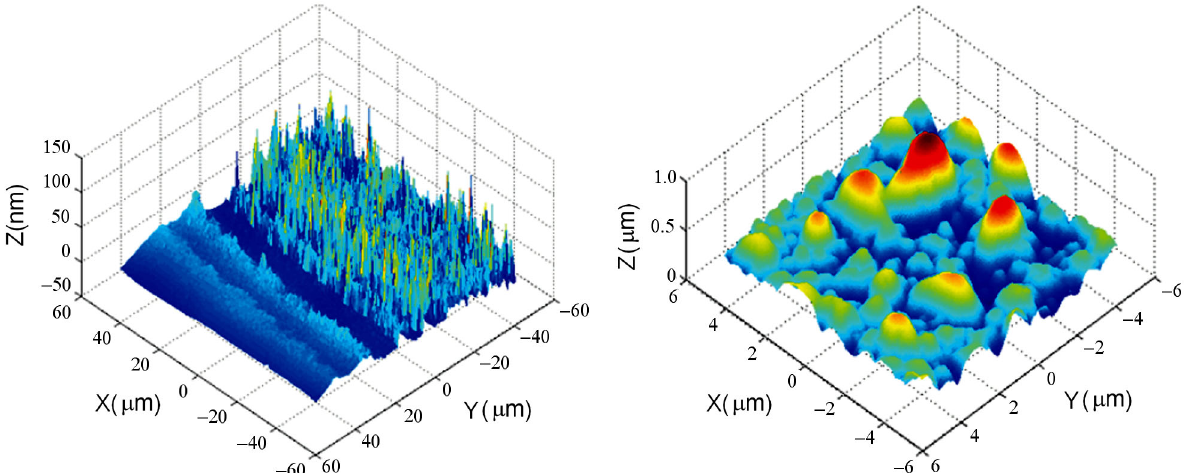
FIG. 8. Atomic force micrographs of the central damage area. Left: 100 (cid:2) 100 (cid:1) m 2 scan at the interface of the brownish area and the central damage site. Right: 10 (cid:2) 10 (cid:1) m 2 scan at the mean distance between the center and edge of the central damage site. Given that the distribution of crystal strain regions is radial, we can collapse the spatial data down to one dimen- sion, and plot the number of counts on the CCD detector as a function of both position along the diameter of the damage region and diffraction angle. This is shown in Fig. 11. The induced crystal strain is proportional to the deviation of the diffraction angle from the Si(004) peak (rightmost red region). The crystal strain is symmetric about the damage site center, and is sharply peaked on either side of the electrostatic center (here at x (cid:4) 8 mm ). The smallest diffraction angle corresponds to the region of largest atomic spacing. The annular region that first